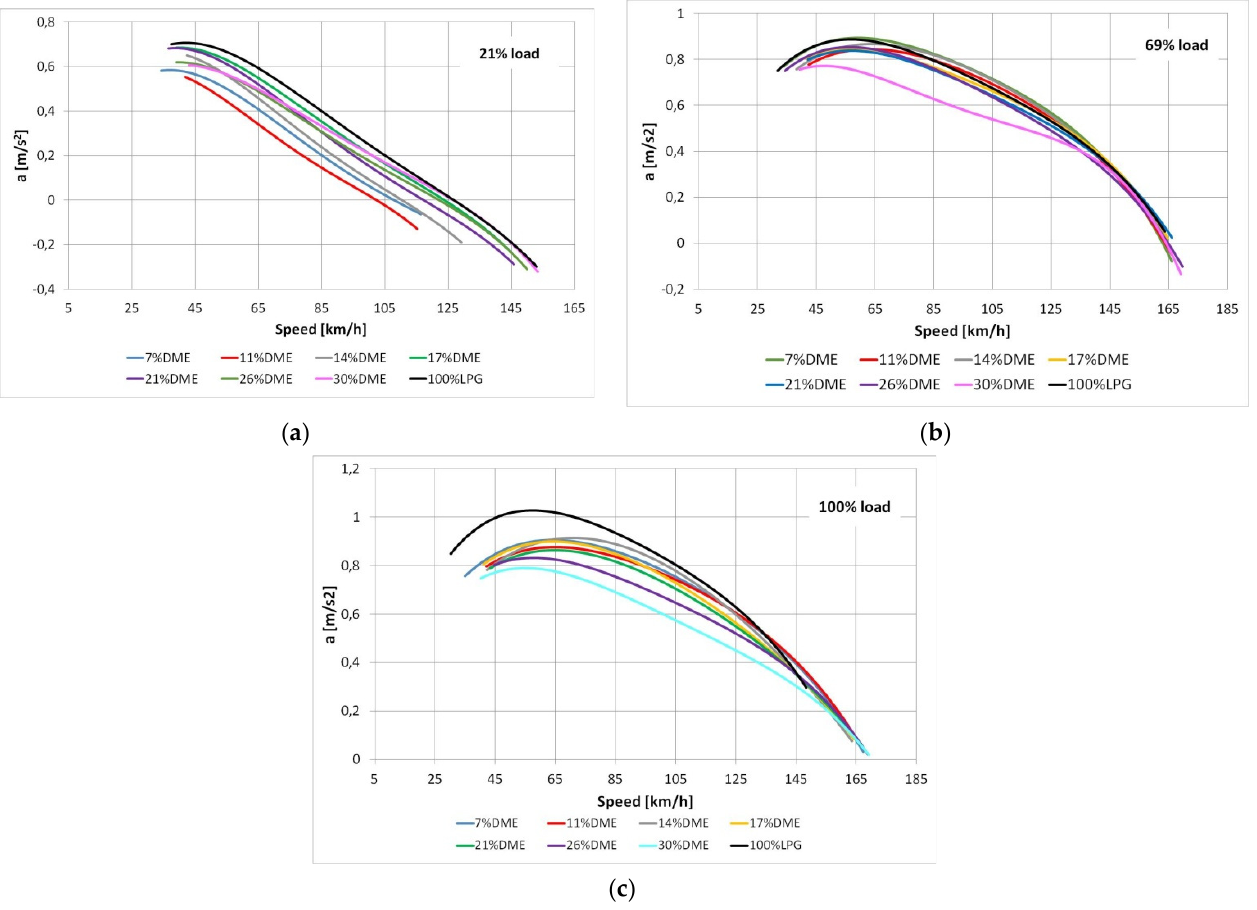
Figure 11. Vehicle acceleration: for fifth gear for different mass fraction of DME and ( a ) 21% load, ( b ) 69% load, ( c ) 100% load.